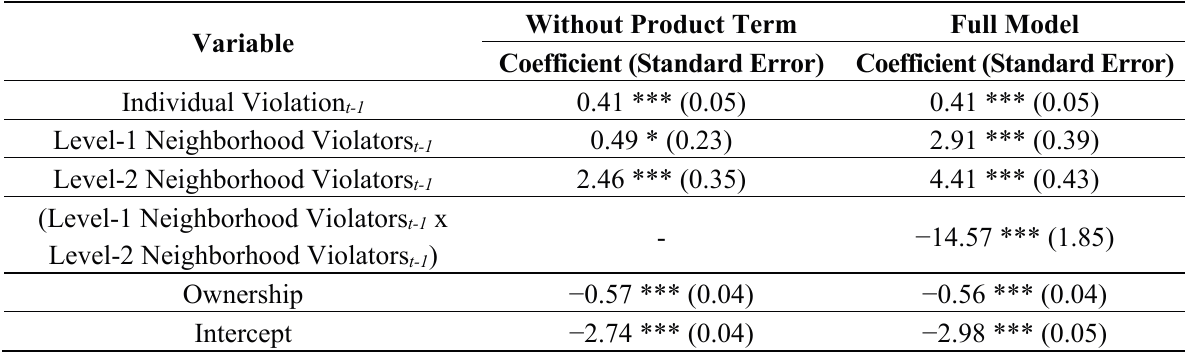
Table 2. Relogit estimation results, dependent variable = individual violation in period t